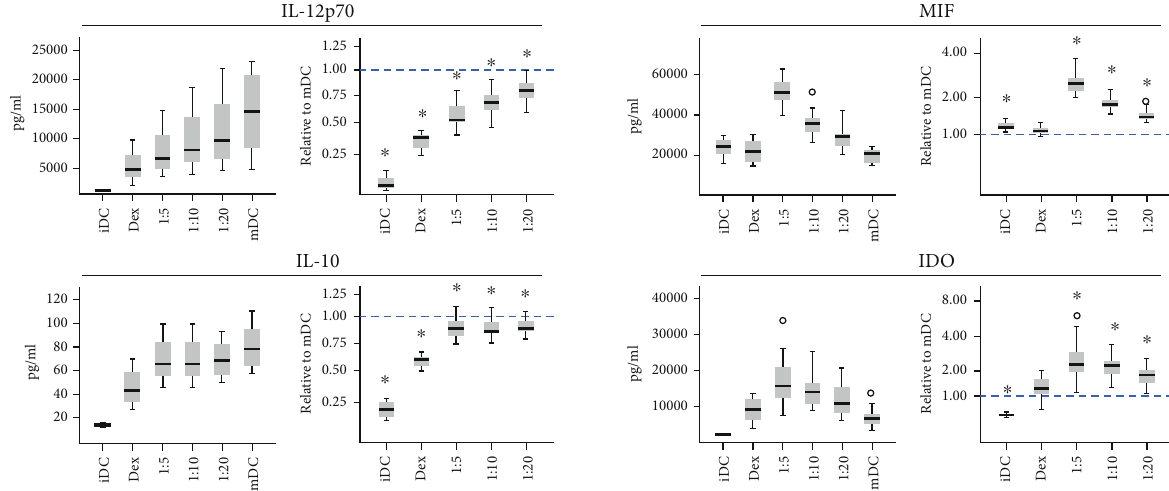
Figure 4: Absolute and relative concentrations of IL-12p70, IL-10, MIF, and IDO. 1 :5-1: 20 refer to ratios of ASC :DC. iDC: immature dendritic cell; Dex: dexamethasone control; mDC: mature dendritic cell; ASC: adipose tissue-derived stromal cell. Signi fi cant di ff erences from mDC (adjusted p ≤ 0 : 05 ) marked with an asterisk ( ∗ ). n = 20 , resulting from 5 ASC donors and 4 DC